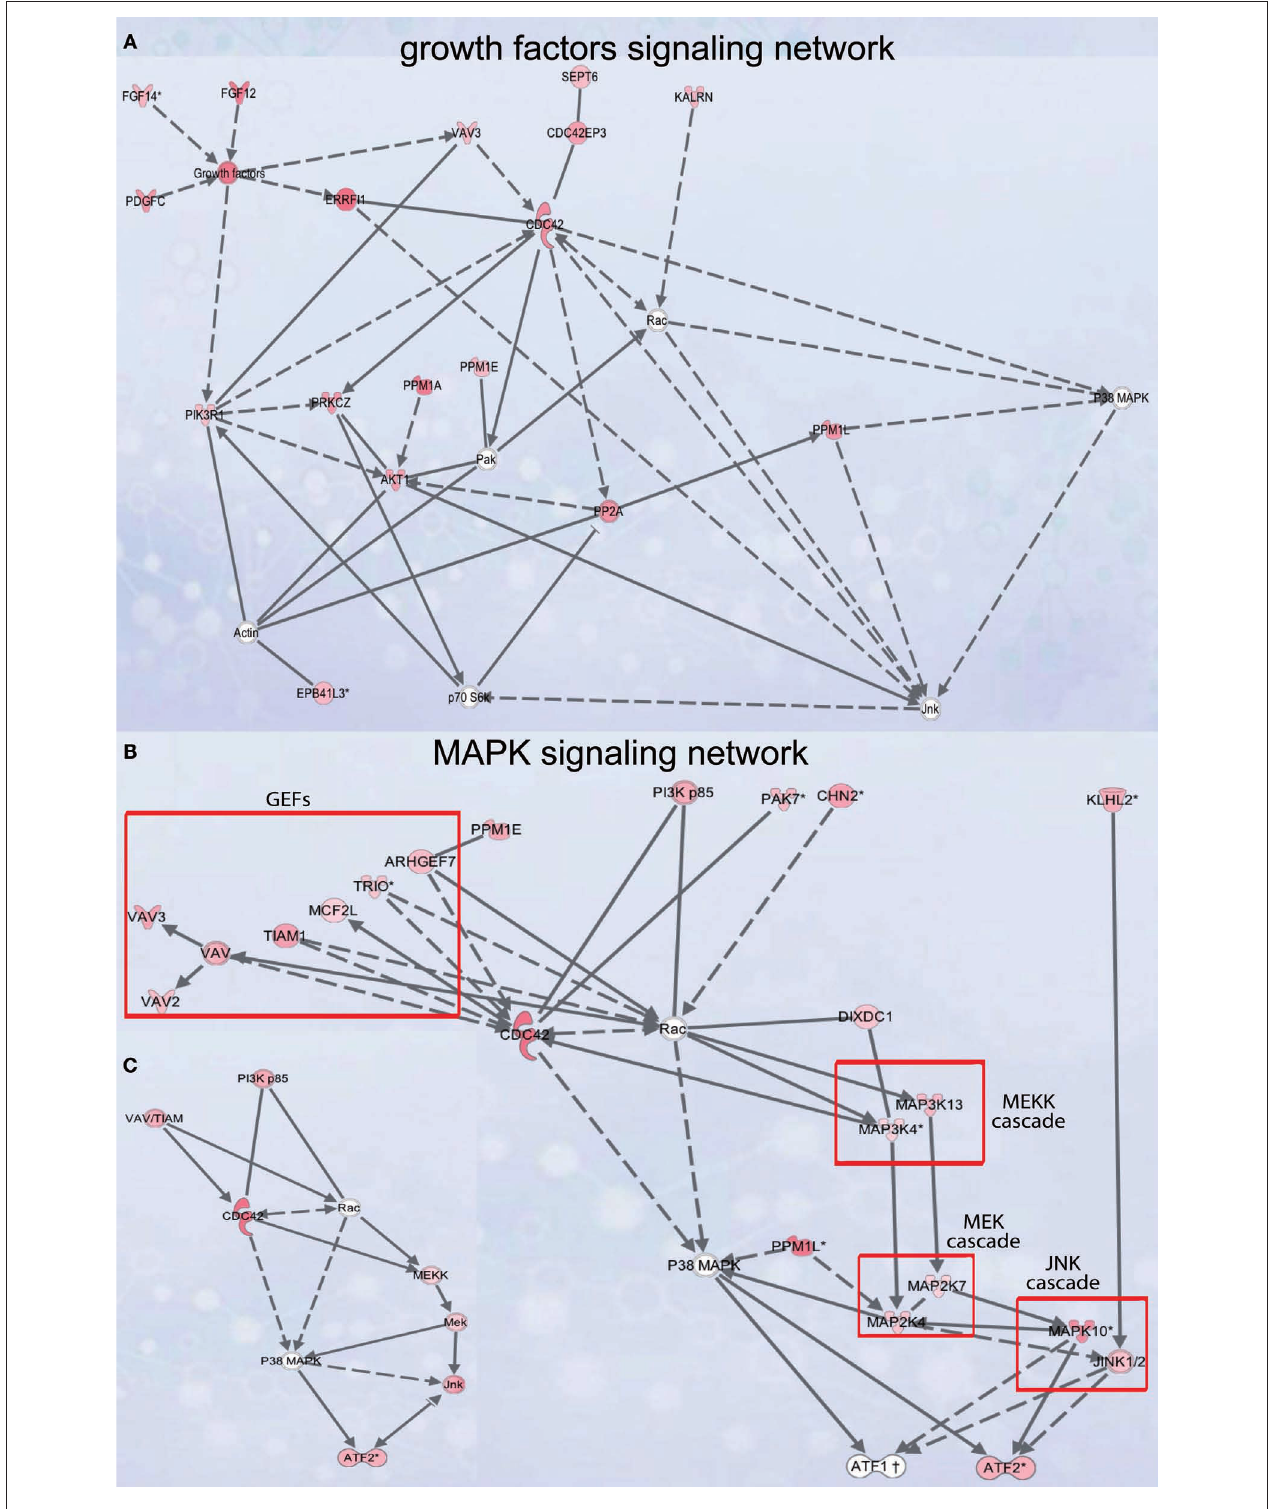
FIGURE 5 | Signaling networks upregulated in migrating neuroblasts. (A) Growth factor signaling network. (B) and (C) MAPK signaling network. (C) is simplifi ed version of (B) . Networks were identifi ed by Ingenuity Pathway Analysis and subsequently modifi ed using Bibliosphere, PathwayArchitect, GO and pathway